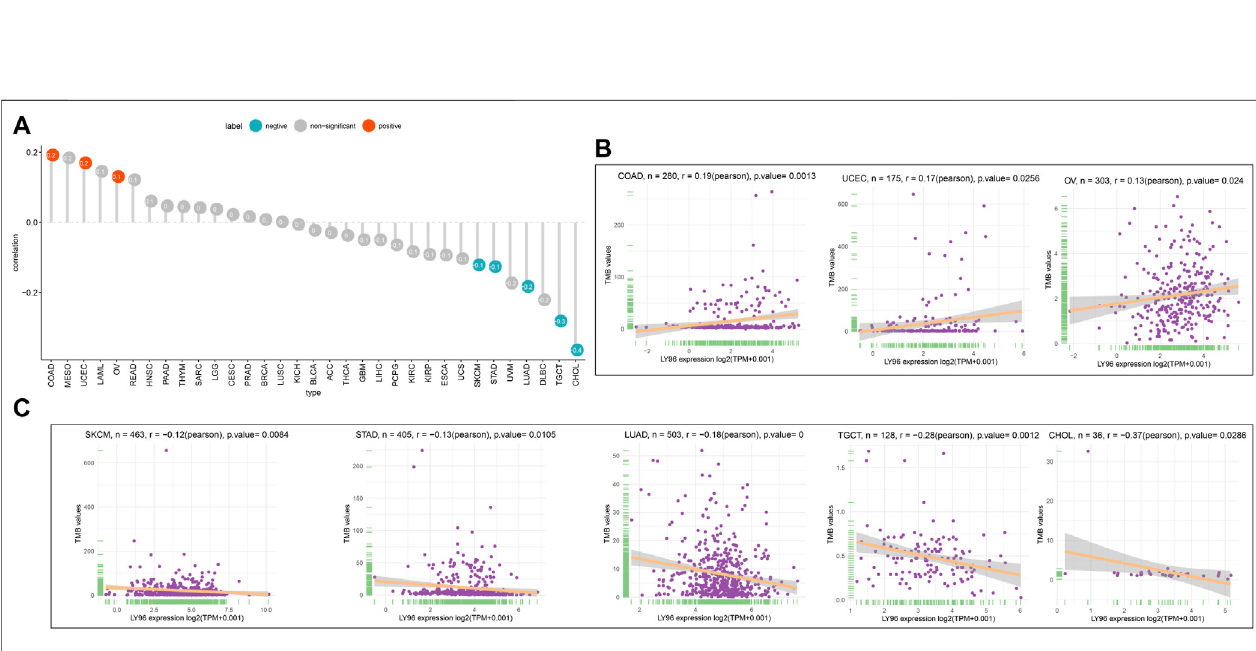
( Supplementary Figures S3D, S3F ). However, patients with high LY96 expression exhibited shorter PFI in GBM, KICH, KIRC, KIRP, LGG, PRAD, THYM, and UVM ( Supplementary Figures S3G – S3N ).